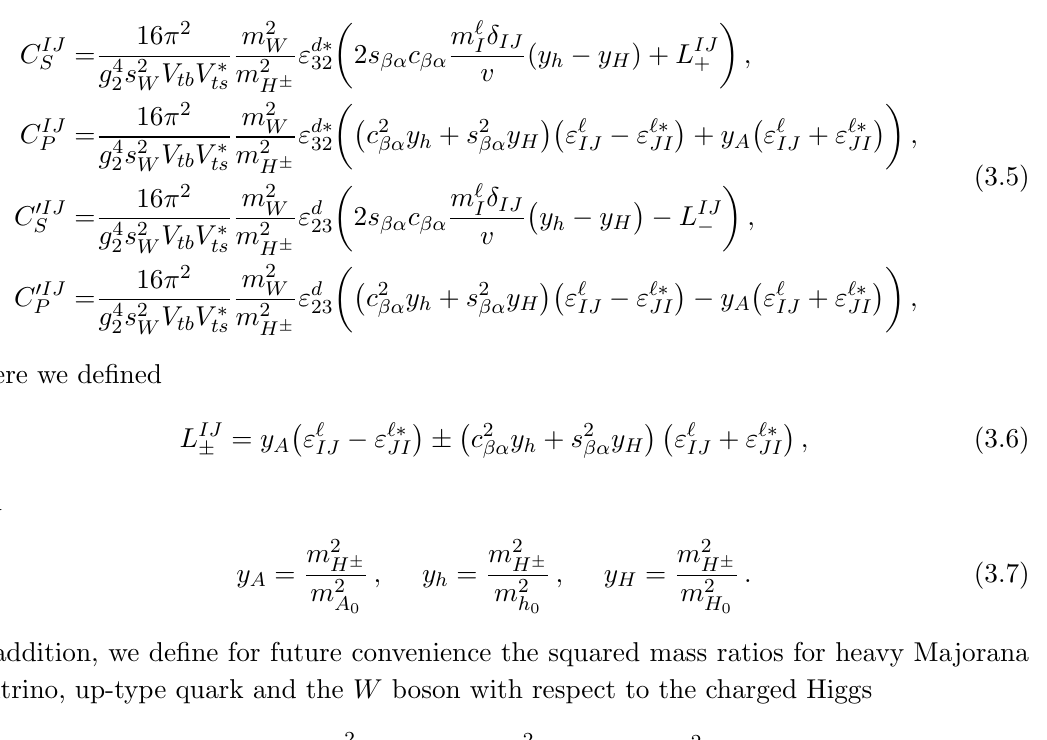
as given in S;P